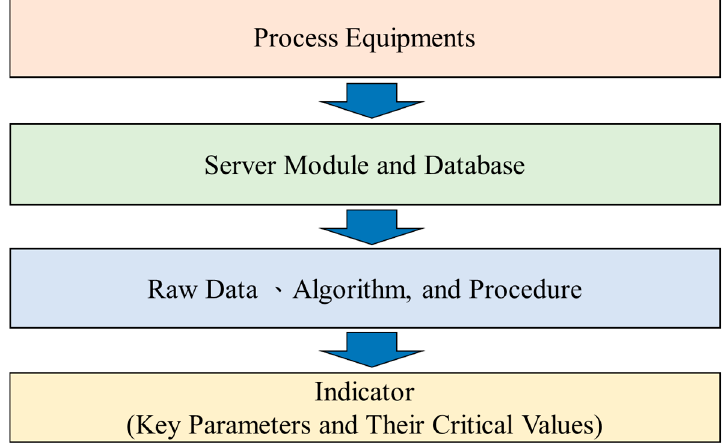
Figure 1. Fault Detection and Classification (FDC).